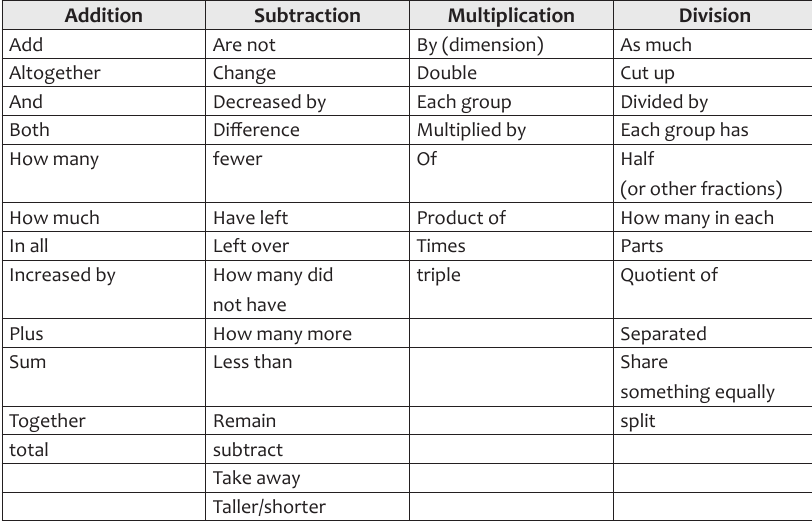
Table 1: Words describing the same